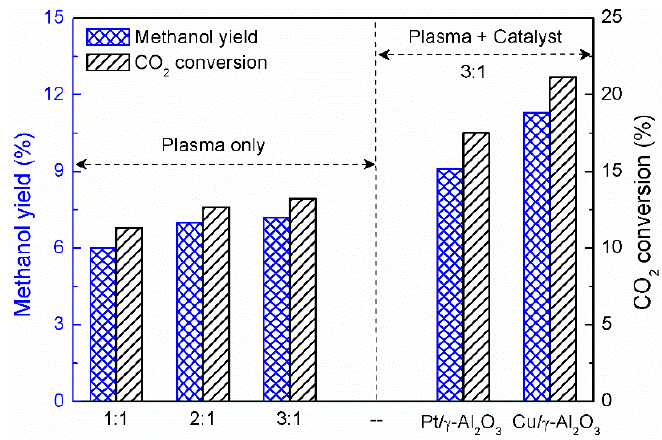
Figure 23. Effect of H 2 /CO 2 molar ratio and catalysts on the reaction performance of the plasma hydrogenation process, reprinted with permission from [125]. Copyright American Chemical Society, 2017.